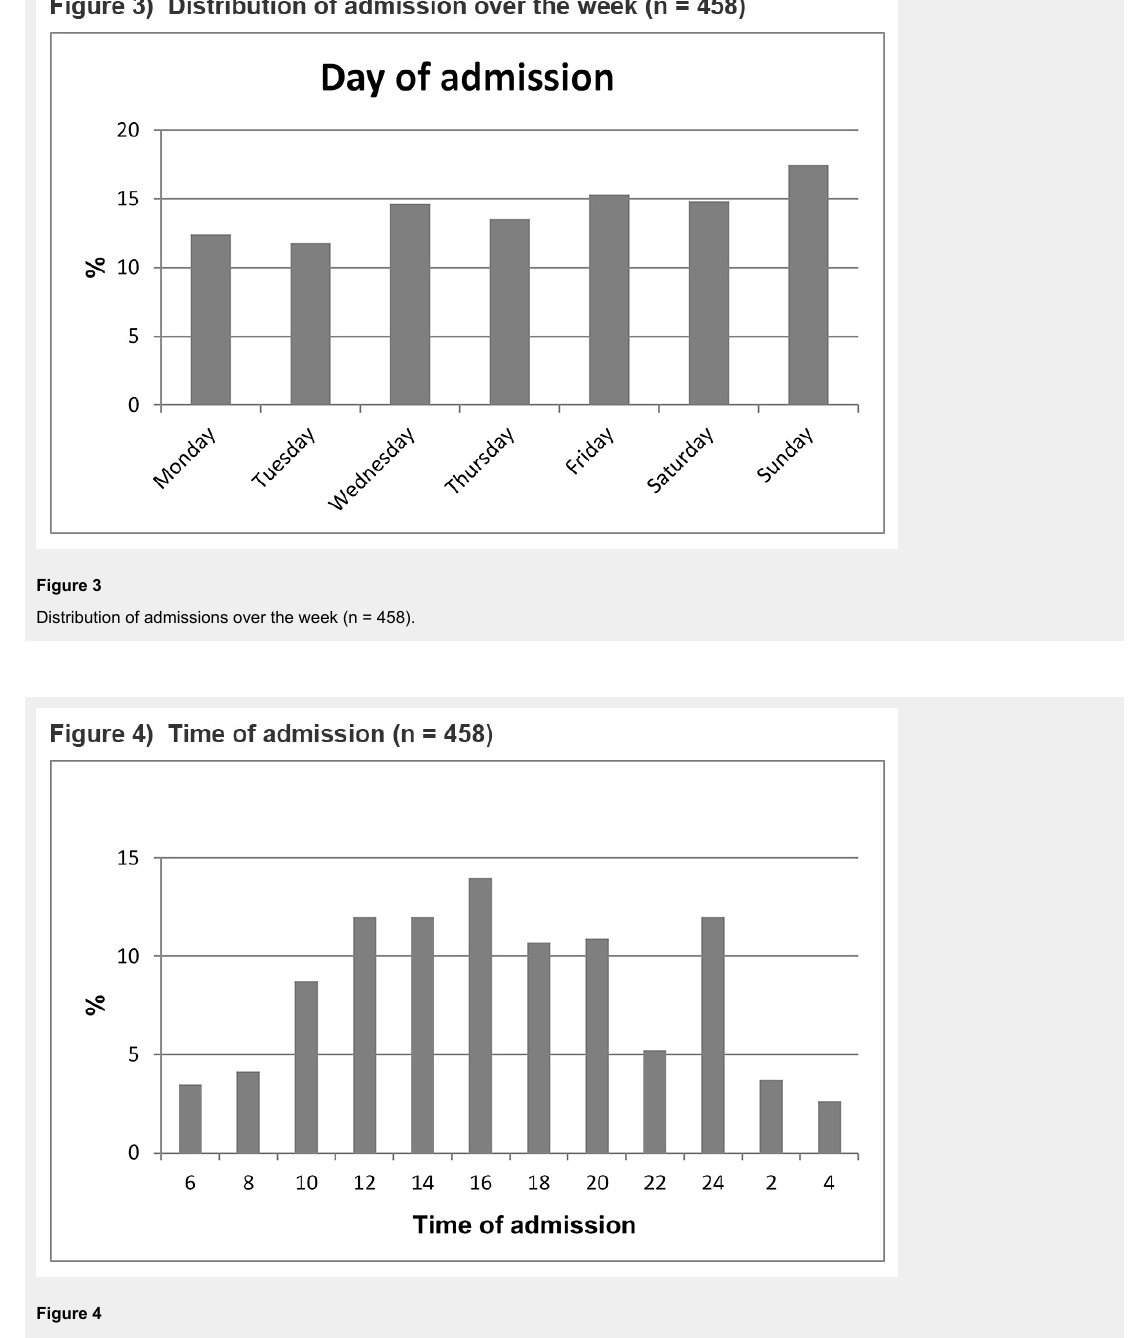
Figure 4 Distribution of admissions over the day (n =